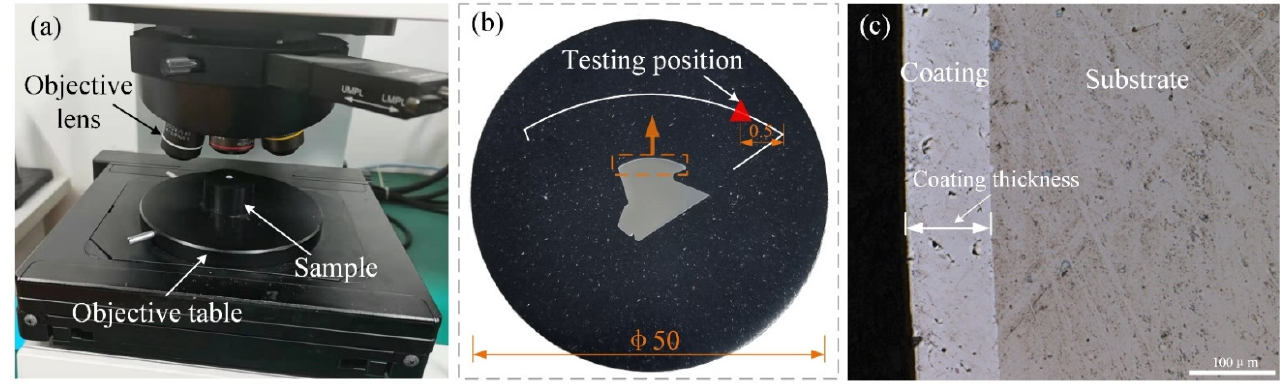
Figure 12. Coating thickness testing: ( a ) testing procedure; ( b ) testing position; and ( c ) micrograph of the test area.